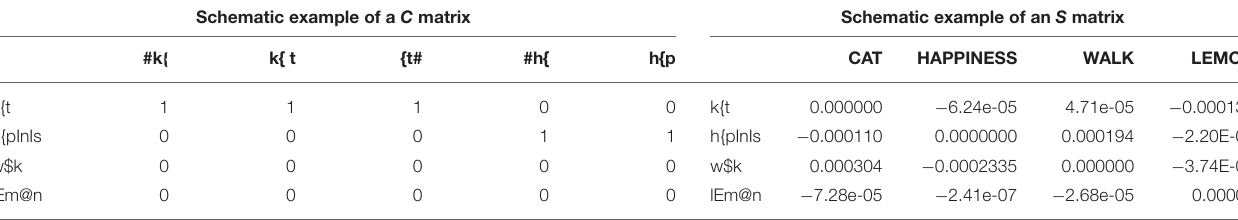
TABLE 2 | Schematic examples of a cue matrix C (left) and a semantic matrix S (right) for the words cat , happiness , walk , and lemon . Schematic example of a C